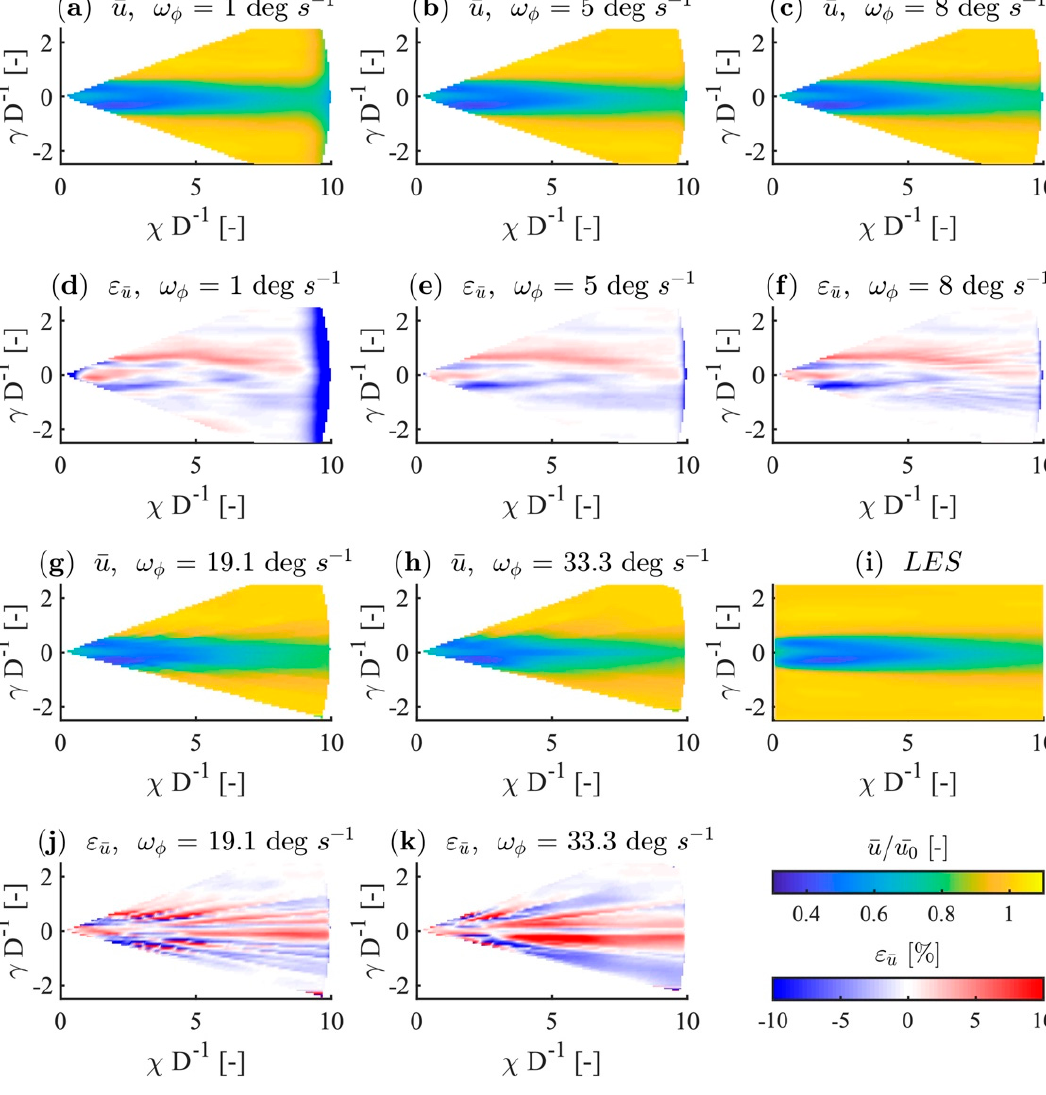
Figure 10. Visualisation of the normalised 10-min averaged wind-speed component ( u ) of the propagated PPI data and ( d – f , j , k ) the corresponding flow deviations ( ε u ) in comparison to ( i ) the normalised 10-min averaged wind-speed component ( u ) of the LES data.